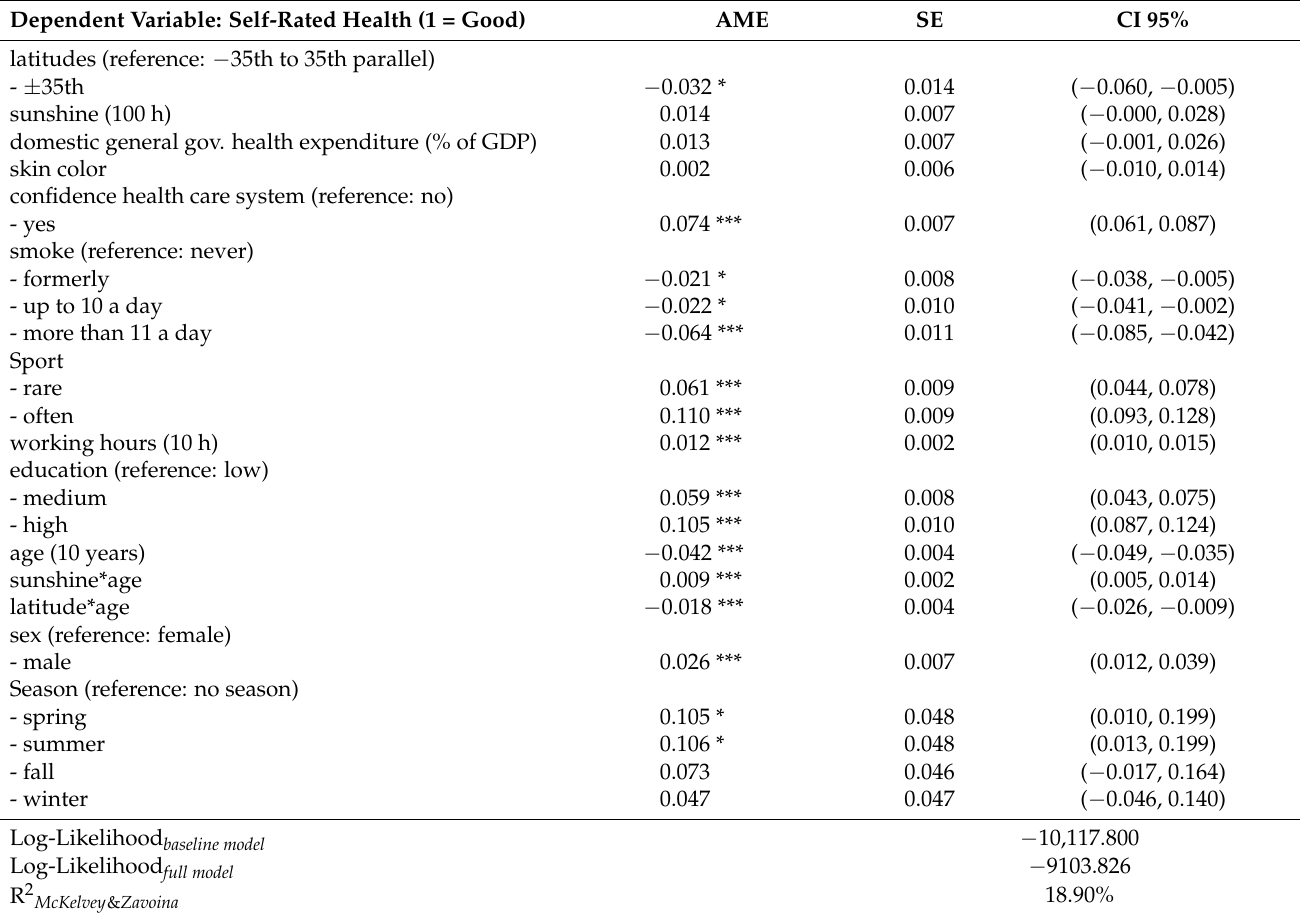
Table 5. Varying intercepts constant slope model estimates including all control variables without mediation for